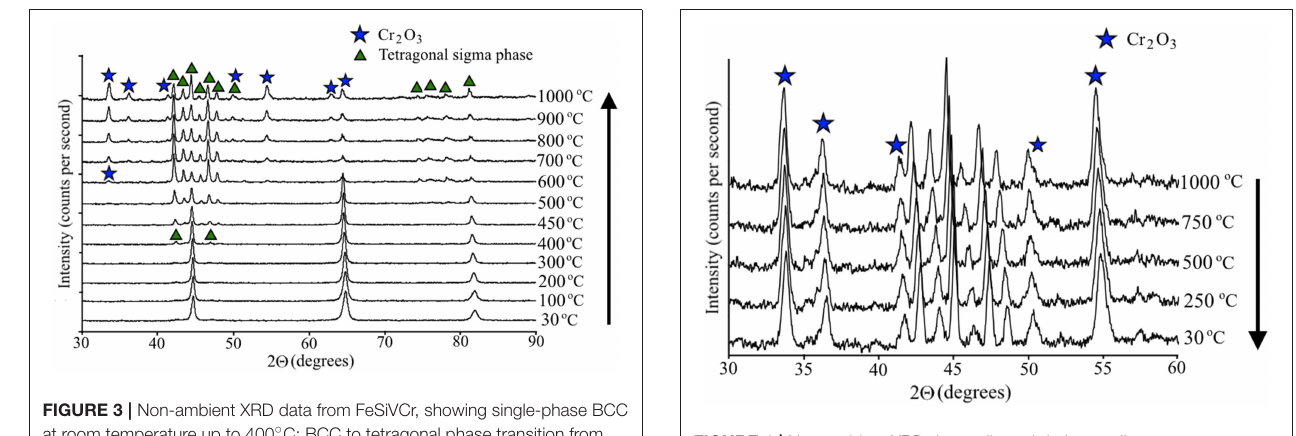
FIGURE 4 | Non-ambient XRD data collected during cooling to room temperature, from 1000 ◦ C. Peaks from both sigma and Cr 2 O 3 phases are retained in all